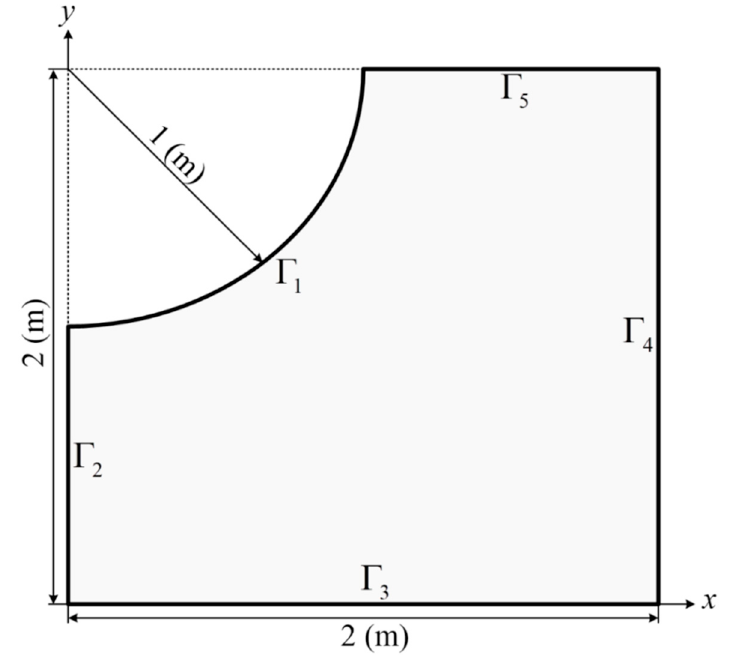
Figure 7. The configuration of the boundary condition.